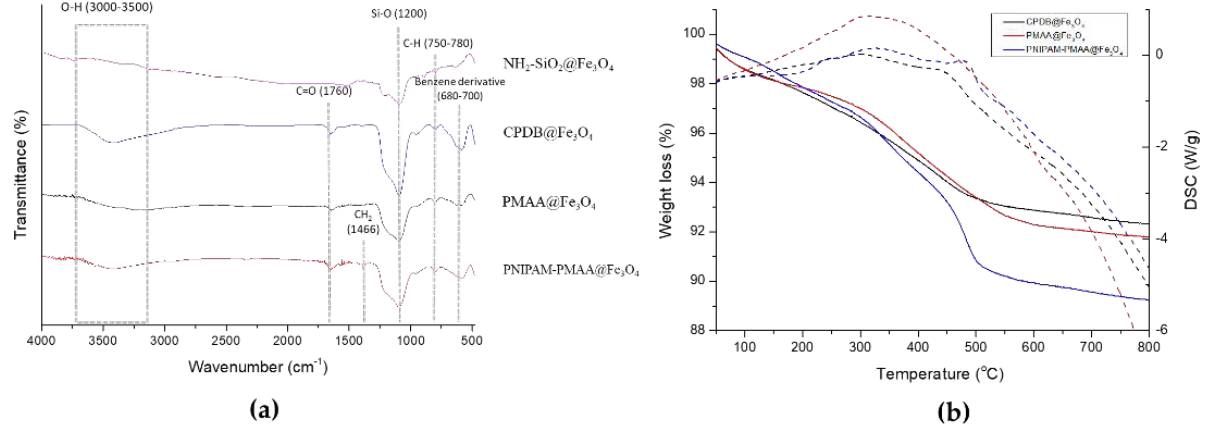
Figure 4. ( a ) FTIR spectra of HO@Fe 3 O 4 , NH 2 -SiO 2 @Fe 3 O 4 , CPDB@Fe 3 O 4, PMAA@ Fe 3 O 4 , and PNIPAM-PMMA@Fe 3 O 4 and ( b ) thermogravimetric analysis (TGA) of CPDB@Fe 3 O 4 , PMAA@ Fe 3 O 4 and PNIPAM-PMMA@Fe 3 O 4. The dashed lines indicate the heat flow variation of CPDB@Fe 3 O 4 , PMAA@ Fe 3 O 4 , and PNIPAM-PMMA @Fe 3 O 4 ,